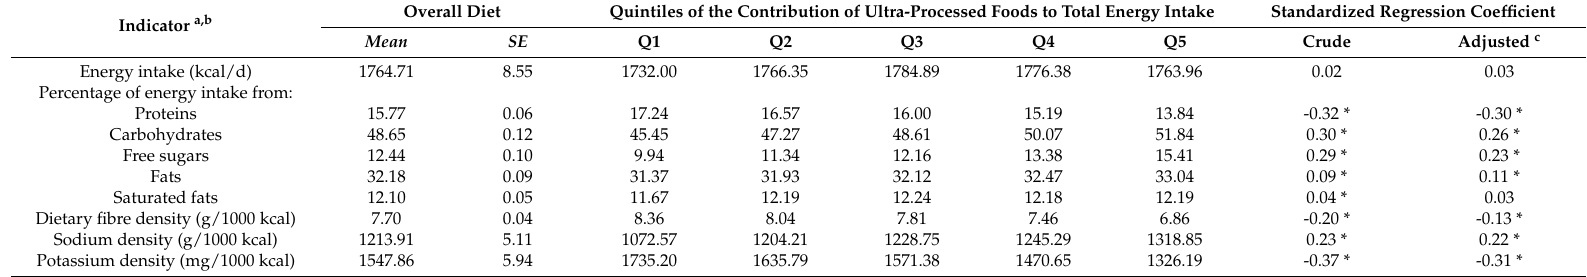
Table 3. Nutritional indicators of the overall diet across strata of increasing ultra-processed food consumption. U.K. population aged 1.5 years or over (2008–2014). Indicator a,b